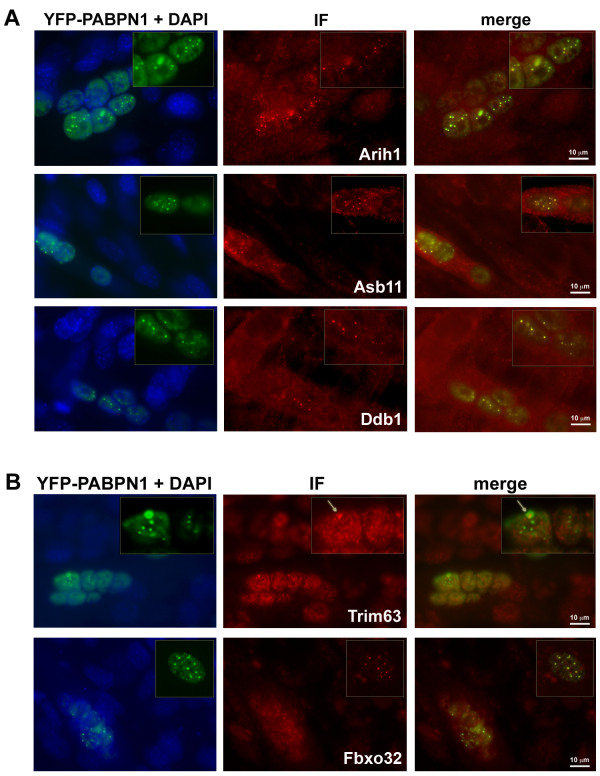
Co-localization of selected E3 ligases with INI in C2C12 myotubes expressing YFP-Ala16PABPN1. Immunostaining of E3-ligases was visualized with Alexa-594 secondary antibodies. Co-localization with expPABPN1 in myotubes is demonstrated in the merge image. A 2.5X magnification of nuclei containing expPABPN1 aggregates is highlighted in a box. A) Arih1, Asb11 and Ddb1 E3 ligases show consistent co-localization with aggregated YFP-Ala16-PABPN1. B) Trim63 and Fbxo32 E3 ligases show progressively more co-localization with YFP-Ala16-PABPN1 as INI size increases. Scale bar is 10 μm.